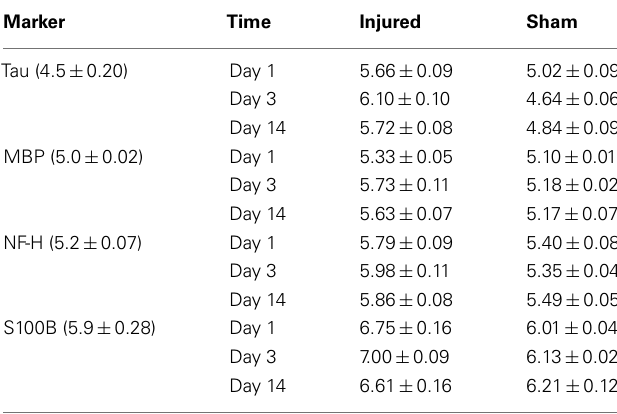
Table 1 | Results of RPPM.